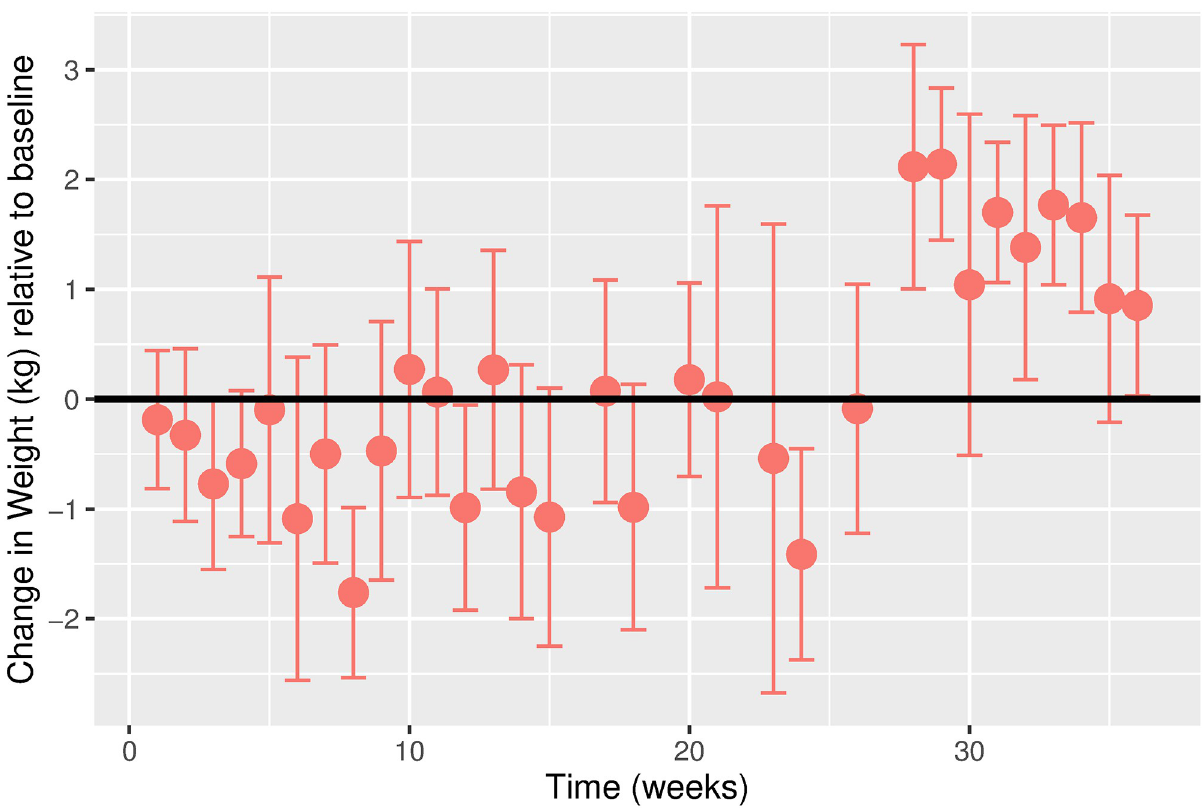
Fig 5. Estimated change in weight (kg) relative to baseline over time in weeks for non-prediabetic and non-diabetic individuals (HbA1c < 5.7%). Error bars represent the 95% confidence intervals. Change in Weight (kg) relative to baseline. Time (weeks). Error bars represent the 95% confidence